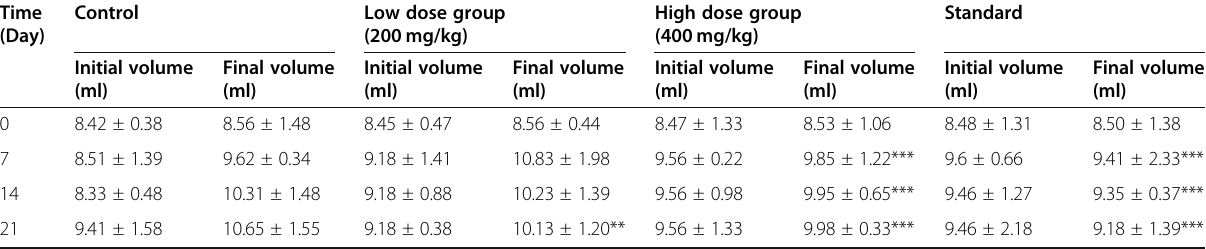
Table 5 Effect of Martynia annua extract on CFA induced paw edema in rats Time Control (Day)